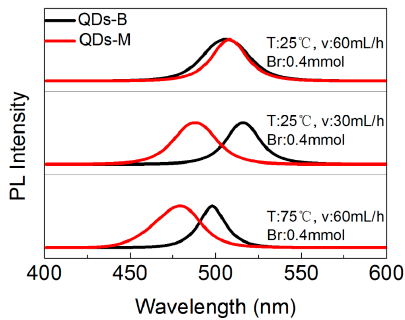
represents dosage of PbBr 2 .)